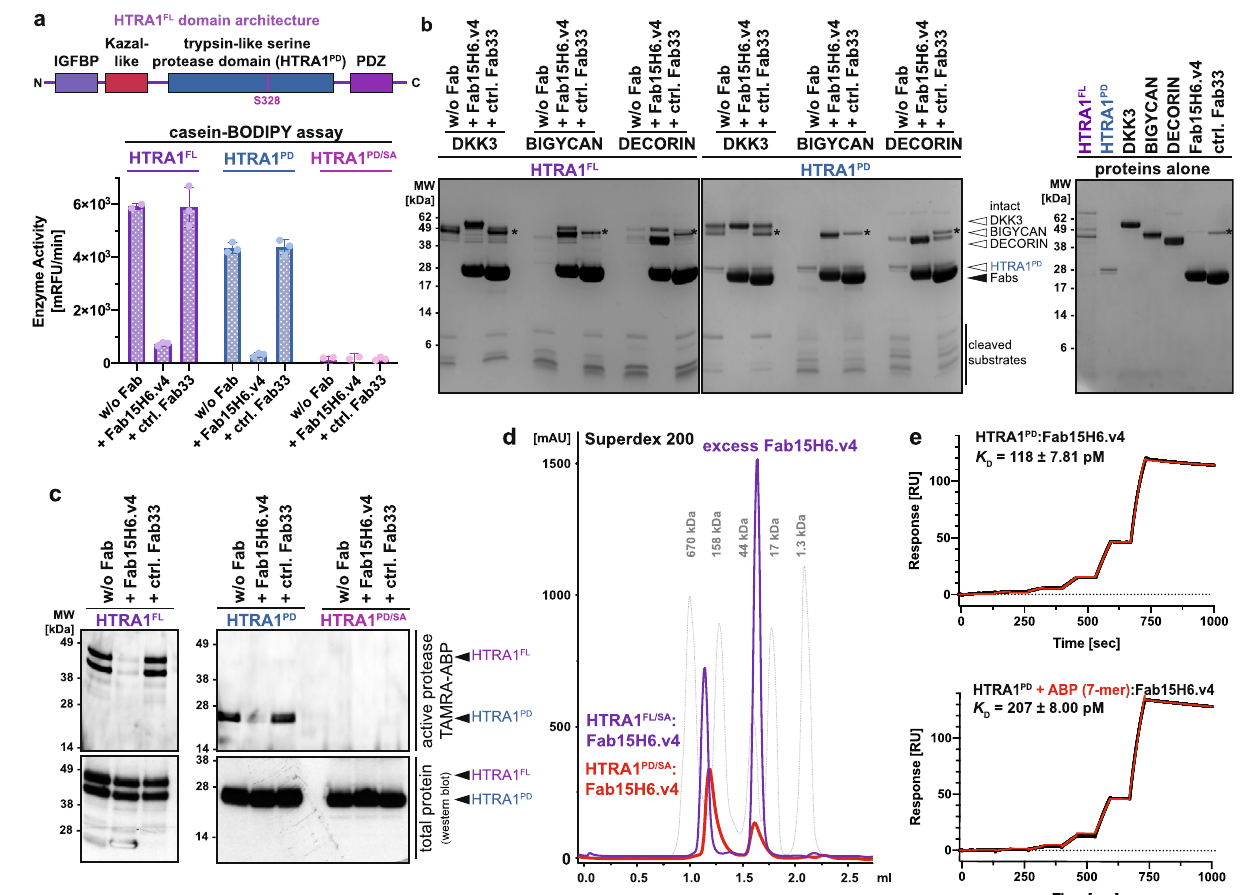
Fig. 1 | Fab15H6.v4 inhibits the enzymatic activity of HTRA1 FL and HTRA1 PD through an allosteric mechanism. a HTRA1 FL domain architecture. Enzyme activityofHTRA1 FL ,HTRA1 PD ,andcatalyticallyinactiveHTRA1 PD/SA inthepresenceof Fab15H6.v4. Control Fab33 (anti-PCSK9) does not affect enzymatic activity. b Cleavage of macromolecular substrates Dickkopf-related protein 3 (DKK3), BIGLYCAN, and DECORIN by HTRA1 FL (51kDa) and HTRA1 PD (24kDa) in the pre- sence of Fab15H6.v4. Right panel: cleavage assay control with individual proteins. Asterisks (*) indicate the contaminant of the control Fab33 preparation. c Labeling of HTRA1 FL , HTRA1 PD , and HTRA1 PD/SA active site using a small fl uorescent activity- basedprobe(TAMRA-ABP)inthepresenceofFab15H6.v4.HTRA1 FL undergoesself-